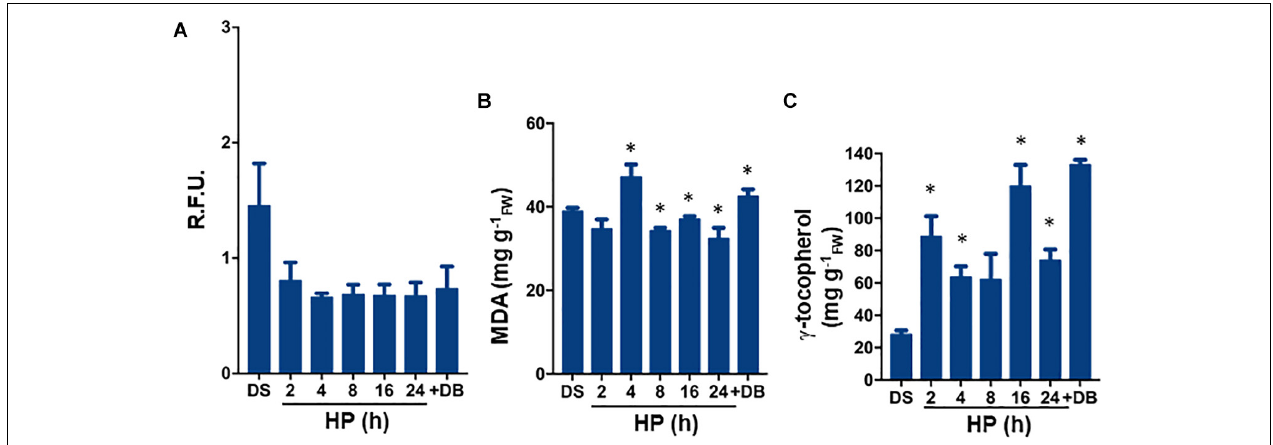
FIGURE 2 | (A) ROS levels measured during hydropriming as well as at the end of dry-back, using the DCF-DA fluorescent dye. (B) Quantification of lipid peroxidation levels by MDA assay carried out during hydropriming as well as at the end of dry-back. (C) Total tocopherol content assessed during hydropriming as well as at the end of dry-back. Values are expressed as mean ± SD of three independent replicates with 15 seeds for each replicate. Asterisks indicate statistically significant differences determined using Student’s t -test ( P < 0.01). DB, dry-back; DCF-DA, dye 2 (cid:48) ,7 (cid:48) -dichlorofluorescein diacetate; DS, dry seed; FW, fresh weight; HP, hydropriming; MDA, malondialdehyde; R.F.U., relative fluorescence unit; ROS, reactive oxygen